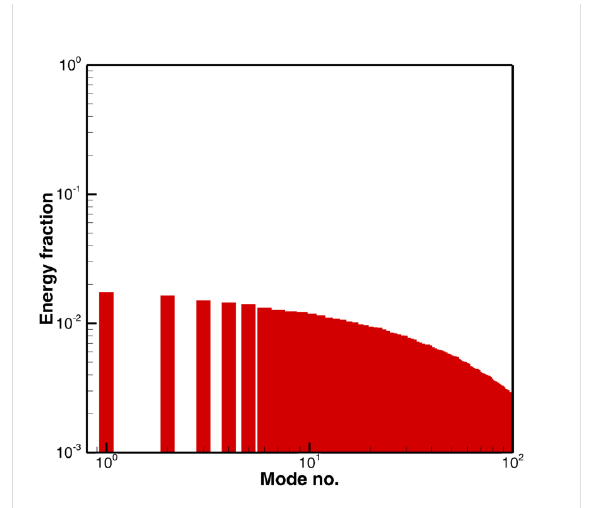
Fig. 12. Energy fraction of POD modes, measuring plane 2 .